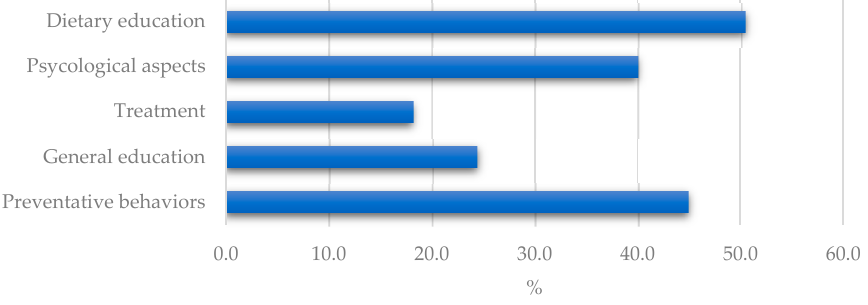
Figure 1. Unmet information